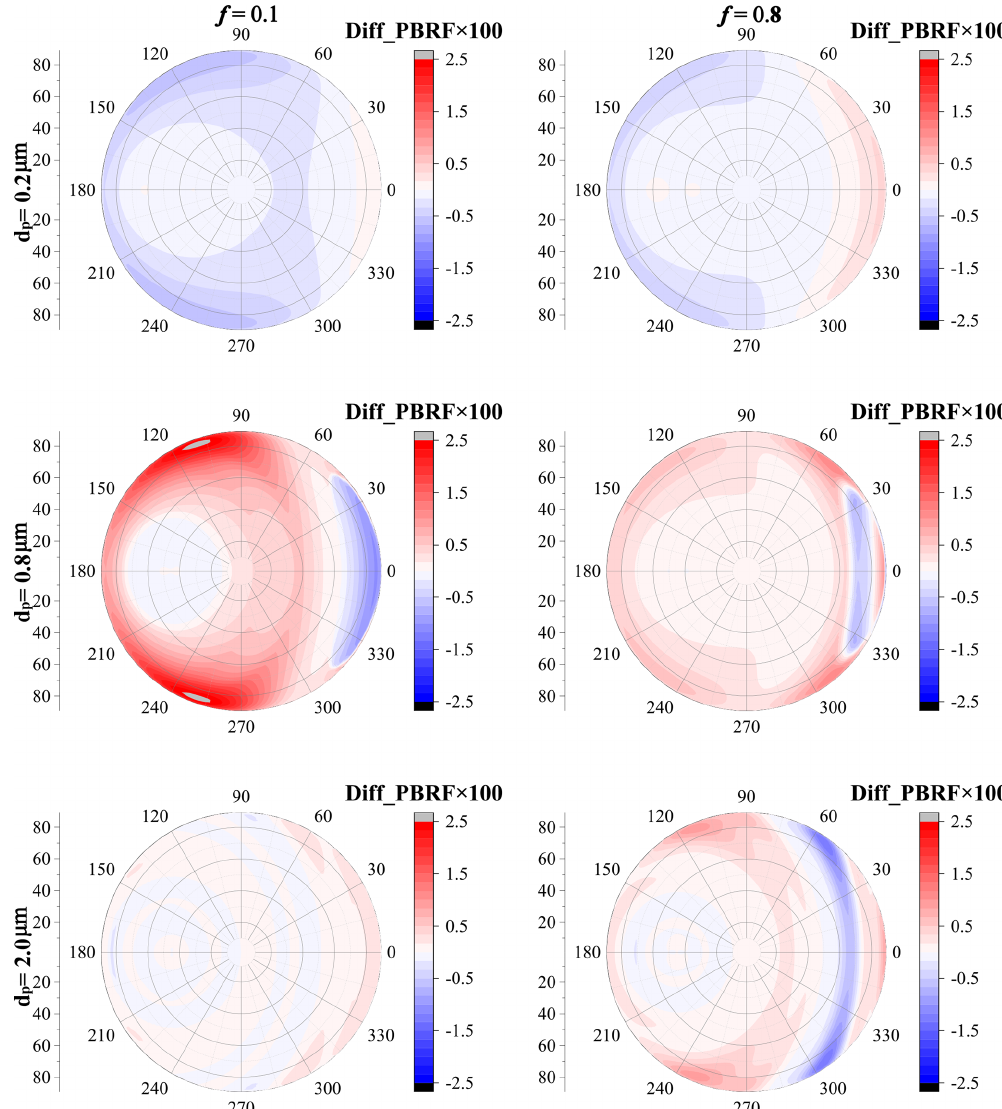
Figure 14. The difference of PBRF between dust with irregular shapes and best-fitted spheroids, where the aspect ratio is 2 : 1 and R = 0.